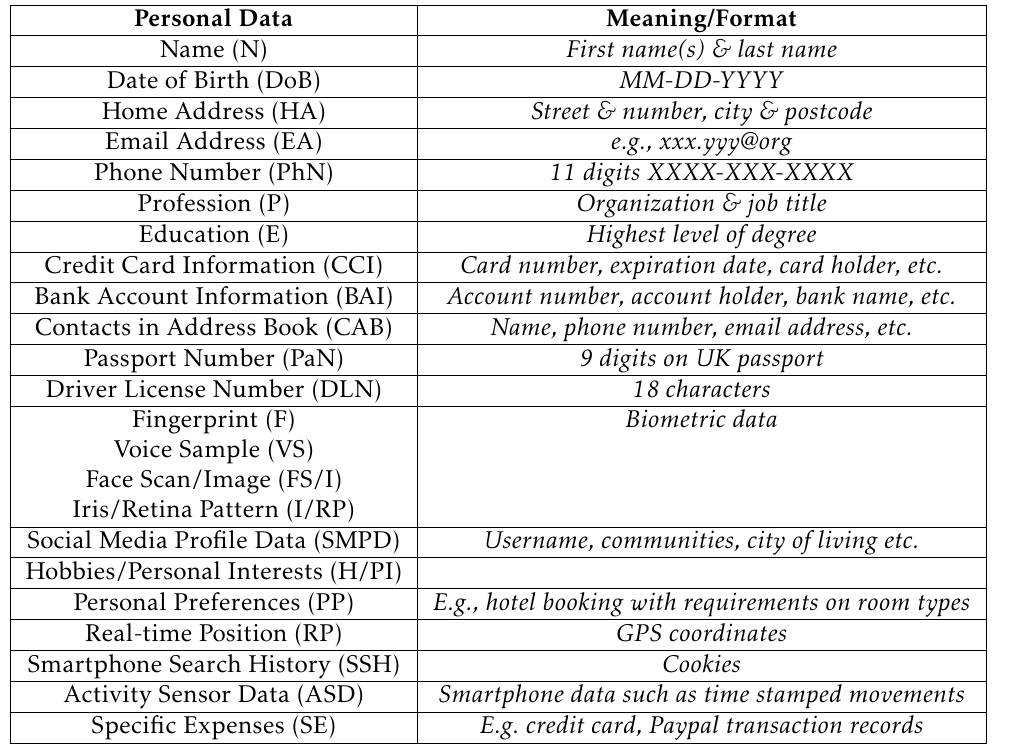
Table 1. 23 types of personal data covered in our survey and the four